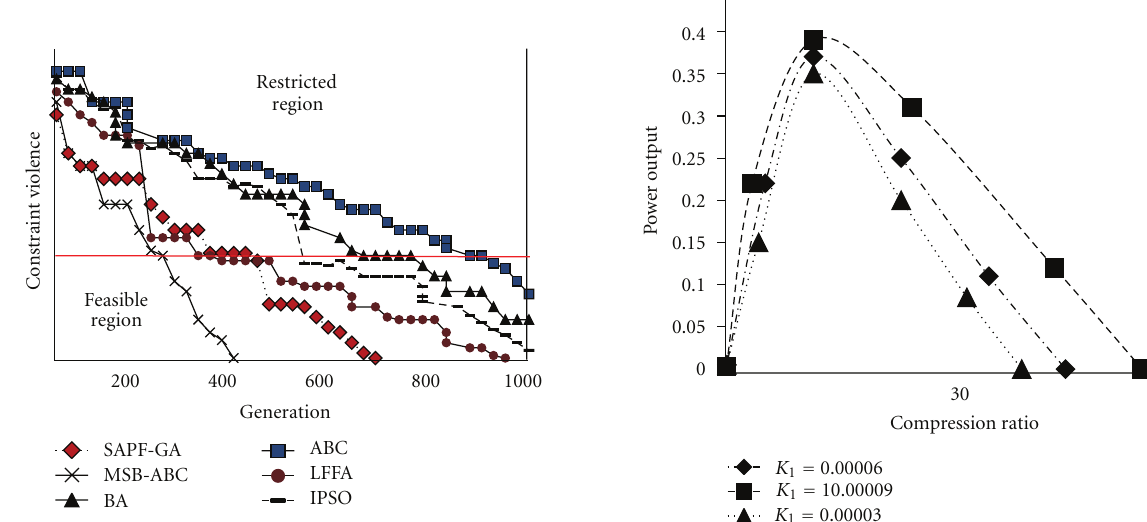
Figure 8: E ff ect of K 1 on the power output with compression